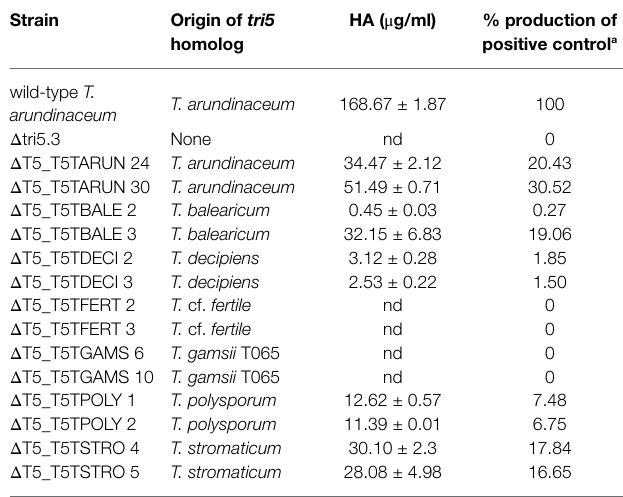
TABLE 5 | Harzianum A (HA) production by transformants of the T. arundinaceum tri5 deletion mutant (strain Δ tri5.3) expressing tri5 homologs from other Trichoderma species.